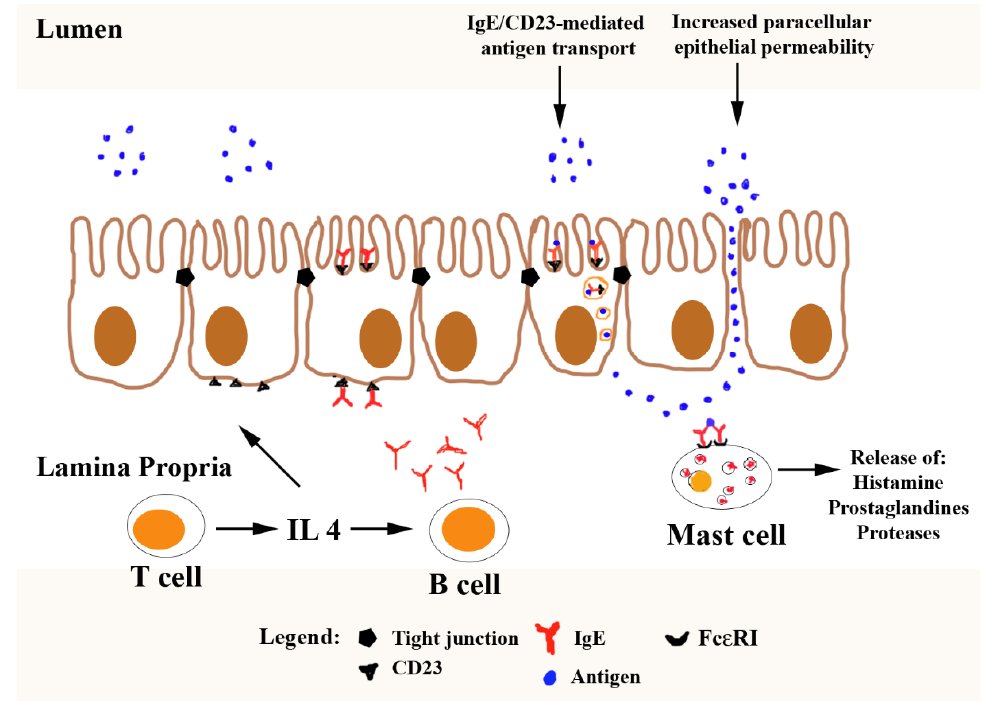
Figure 1. The increased transepithelial transport of allergen mediated by IgE/CD23. IL-4 synthesis by T cells induces isotype switch and production of IgE by B cells. IL-4 is secreted into the serum and intestinal lumen and acts on enterocytes to upregulate the expression of the low-affinity IgE receptor, CD23 (FcεRII). Further, IgE bound to high-affinity receptor Fc ε RI on the mast cell surface and CD23 and consequently, the large amount of antigen can cross the epithelial barrier and bypass the degradation machinery. Adopted and modified from Yu